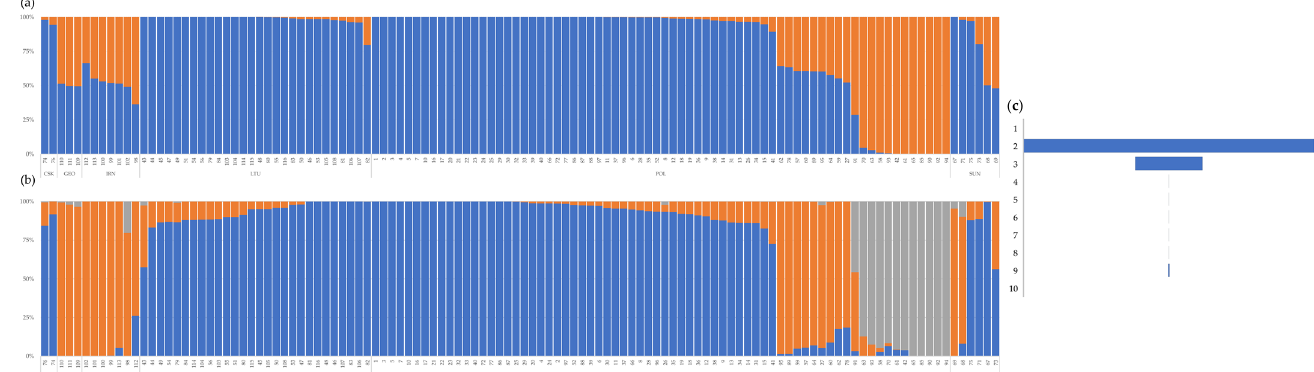
Figure 6. ( a ) Results of 100,000 iterations of the STRUCTURE program [53] for 116 spring barley landraces based on DArTseq data at K = 2, where K is the number of ad hoc groups formed; each vertical bar represents one accession, which is labeled with a sequence number (Table S1). The length of the colored bar indicates the estimated proportion of that sample’s membership in each group. ( b ) Results of 100,000 iterations of the STRUCTURE program [53] for 116 spring barley landraces based on DArTseq data at K = 3, where K is the number of ad hoc groups formed; each vertical bar represents one accession, which is labeled with a sequence number (Table S1). The length of the colored bar indicates the estimated proportion of that sample’s membership in each group; ( c ) the results of ad hoc measure ∆K [54] generated by CLUMPAK software [58] .